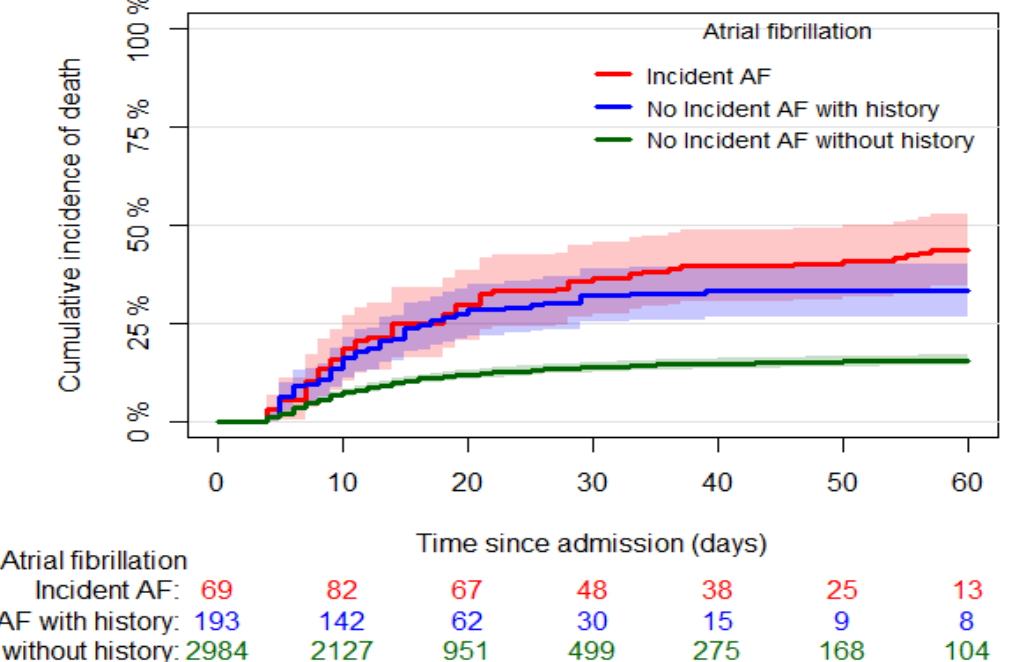
Figure 2. Crude cumulative incidence curves of the all-cause mortality in patients without incident AF, divided according to the presence/absence of previous AF history and patients with incident AF. The origin was fixed at the median time of incident AF (3 days since hospital admission), and late entry was used for AF patients at the time of AF occurrence.